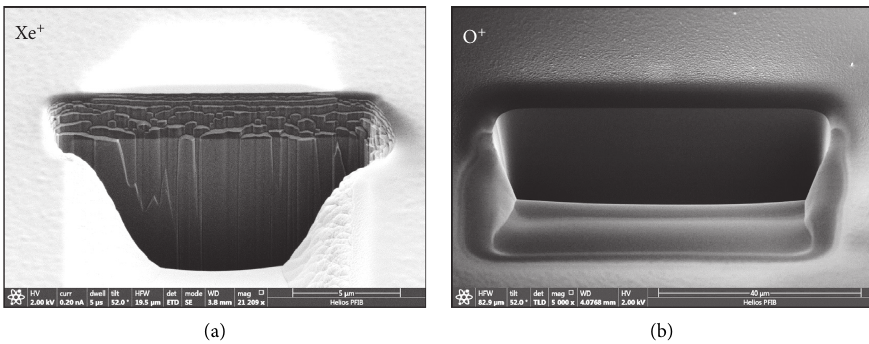
Figure 9: Example of superior cross-sectioning performance of O + vs. Xe + on diamond-like carbon.